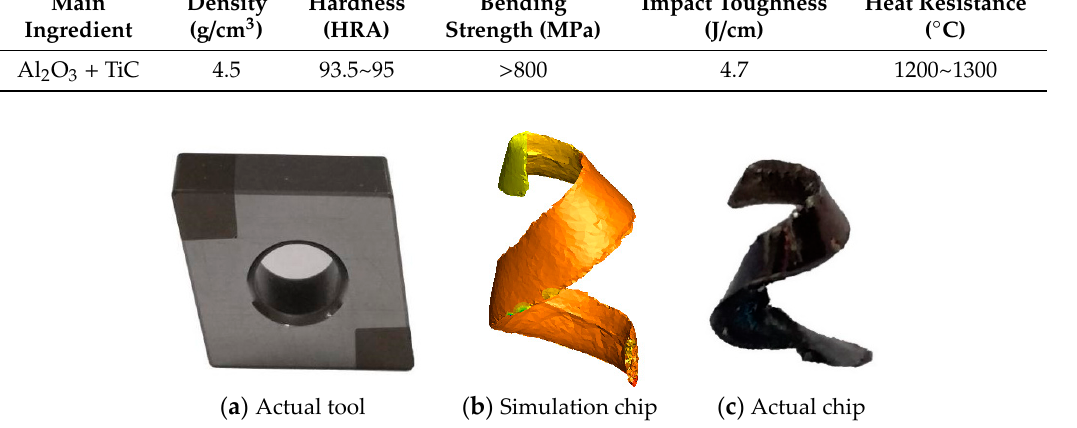
Figure 3. Simulation chip and actual chip comparison.